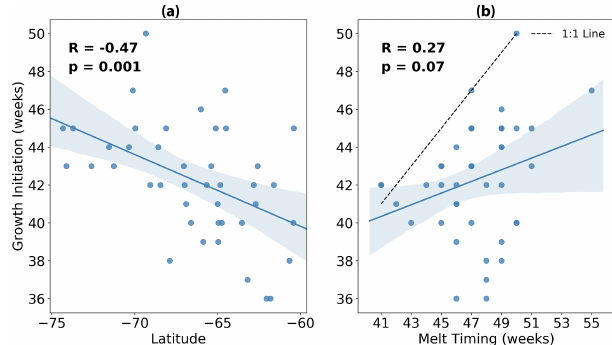
Figure 4. Timing of growth initiation (GI) plotted against (a) aver- age latitude and (b) timing of sea ice melt for each of the 42 melt events shown in Fig. 3. Overlain in blue is the linear regression, with the 95% confidence intervals for 1000 bootstrapped resamples shaded in light blue. In panel (b) , the dashed black line represents the 1 : 1 line.